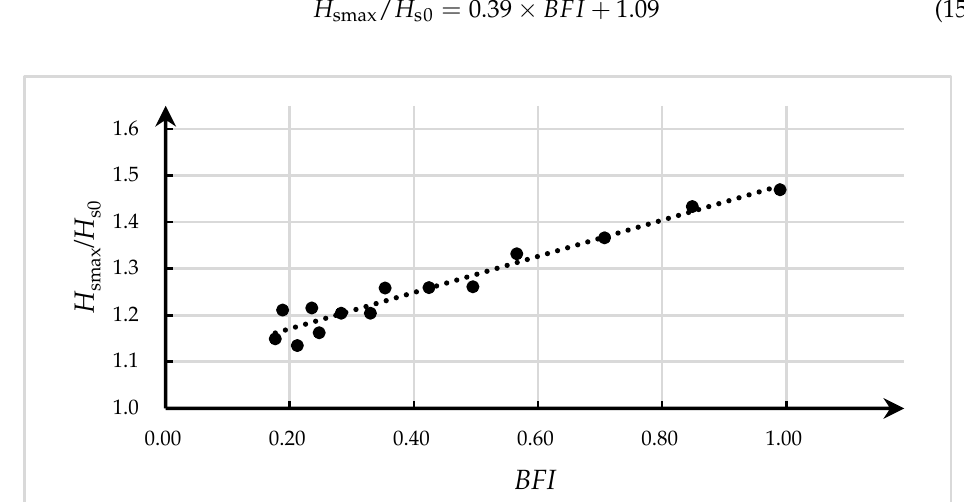
Figure 8. The changing curve of wave height ratio H smax / H s0 at the focal points as BFI changes. The goodness of fit ( R 2 ) in Equation (15) can reach 0.94, indicating that the formula fits well. It is speculated that the calculation results will be more consistent with the line with the increase of the simulation groups. When the value of BFI is more than 0.4, there is a linear relationship between H smax / H s0 and BFI ; whereas the value of BFI is less than 0.4, H smax / H s0 and BFI are weakly linear relation. When the BFI factor is small, in other words, the initial wave steepness of a given spectrum width is small, which indicates that the nonlinear wave interaction is weak. However, a given initial wave steepness has a larger spectrum width, indicating that the frequency bandwidth of wave height distribution is larger. In summary, the smaller the BFI factor is, the smaller H smax / H s0 is; BFI and H smax / H s0 are becoming more independent, when the incident wave nonlinearity is